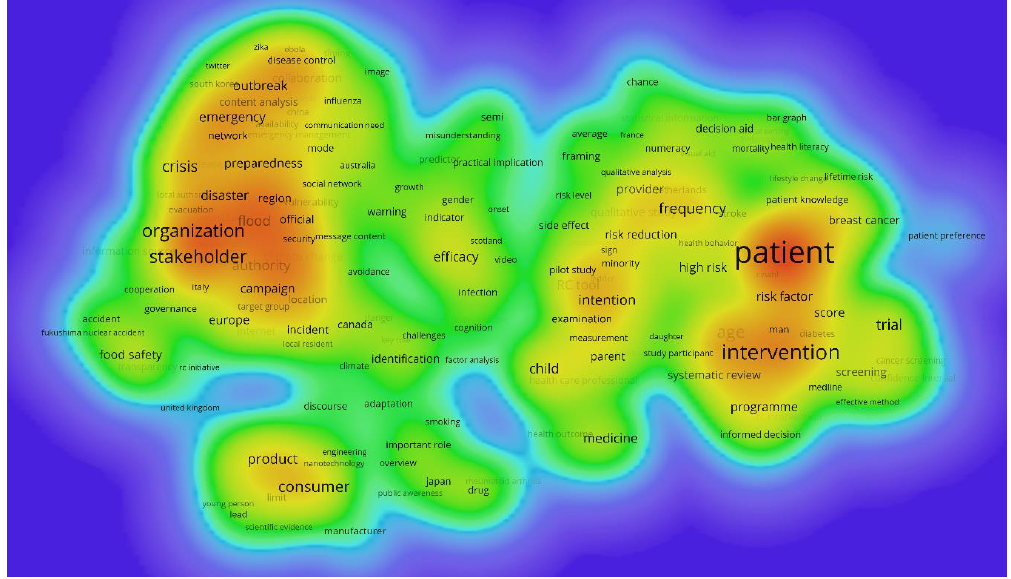
Figure 8. Term density map of risk communication research, average publication year after 2010, (231 terms included).